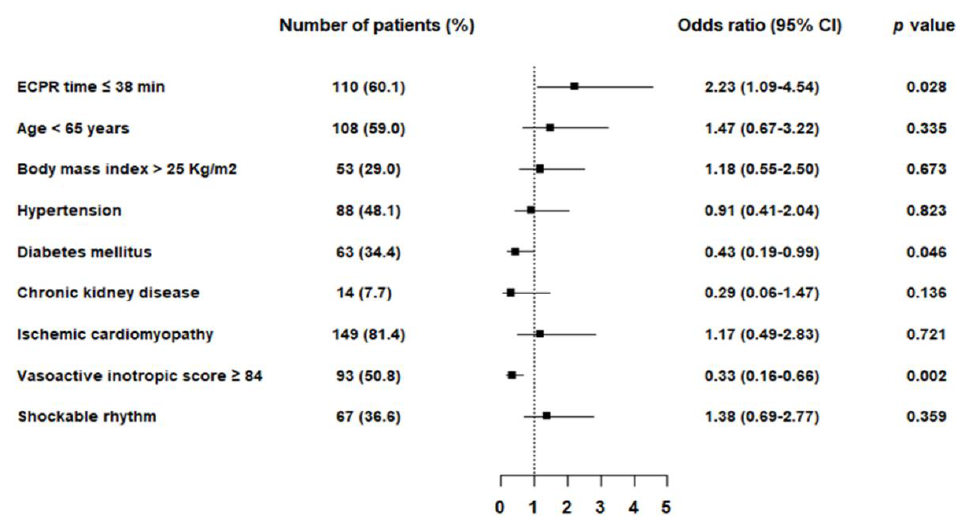
Figure 2. Predictors of survival to discharge. Forest plots show the results of multivariable analysis of predictors of survival to discharge. ECPR = extracorporeal cardiopulmonary resuscitation, CI = confidence interval.